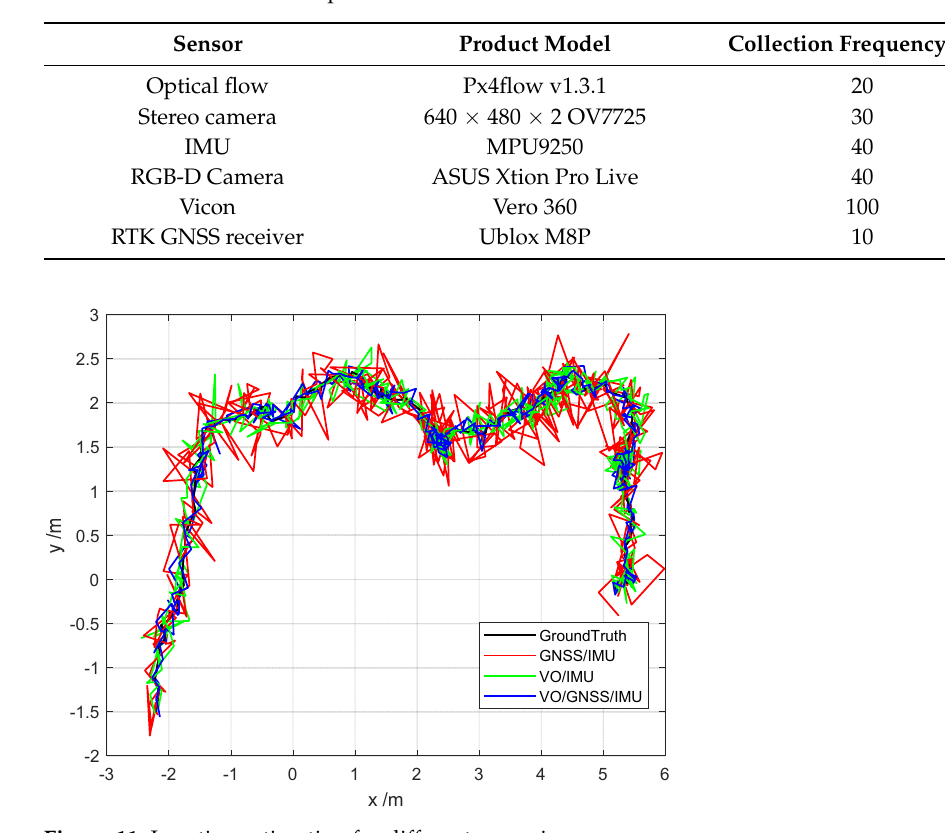
Figure 11. Location estimation for different scenarios.